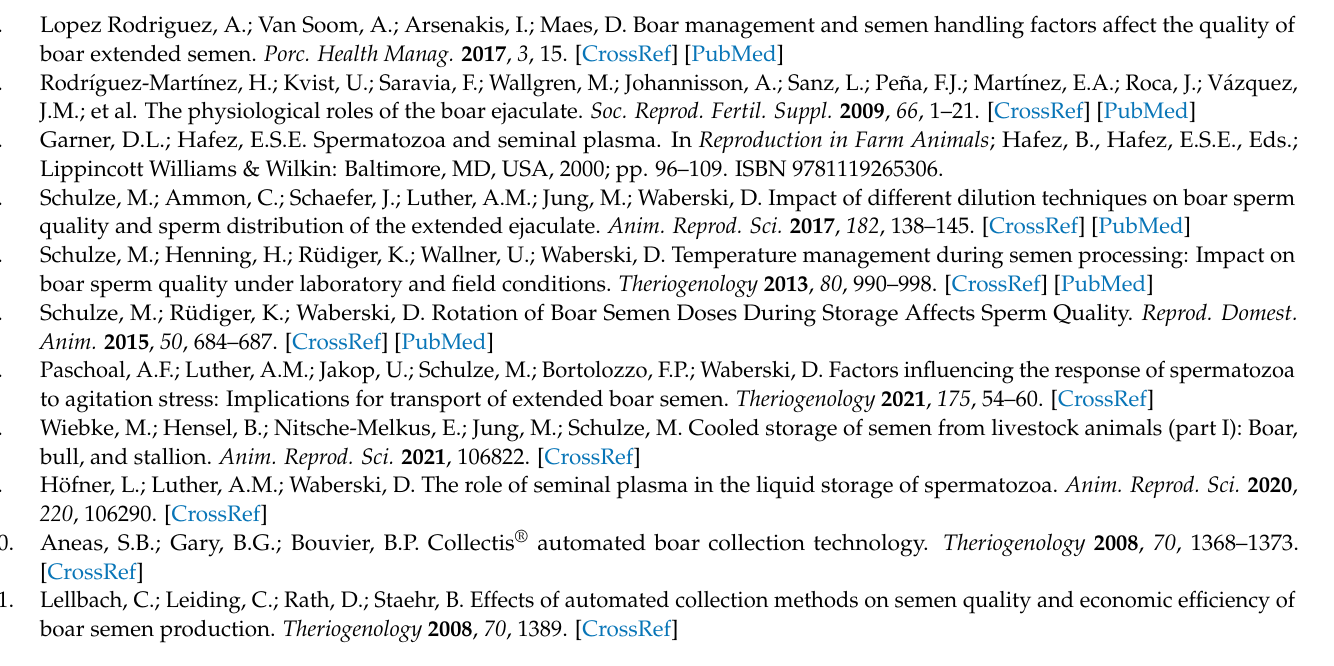
Table S2: Red blood cells and reticulocyte parameters analyzed in three groups of piglets derived from AI (F1, F2, F3). Data are represented as the mean ± SD (standard deviation); Table S3: White blood cell parameters analyzed in the three groups of piglets derived from AI (F1, F2, F3). Data are represented as the mean ± SD (standard deviation); Table S4: Platelet parameters analyzed in the three groups of piglets derived from AI (F1, F2, F3). Data are represented as the mean ± SD (standard deviation); Table S5: Biochemical serum parameters analyzed in the three groups of piglets derived from AI (F1, F2, F3). Data are represented as the mean ± SD (standard